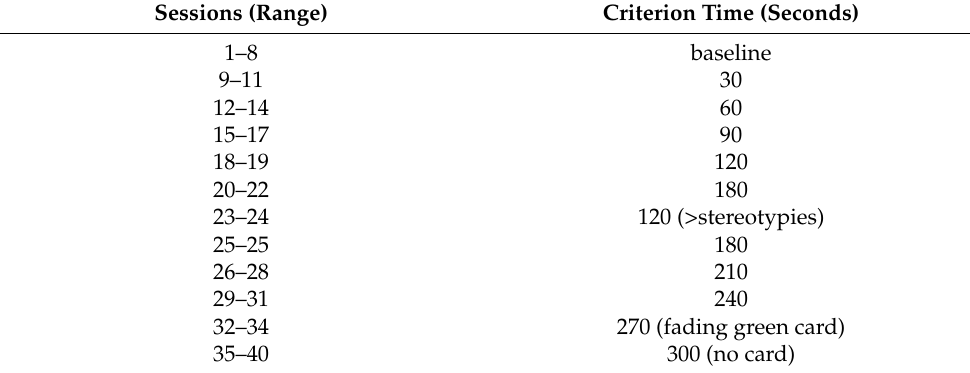
Table 1. Sessions of the intervention with related changing criterion